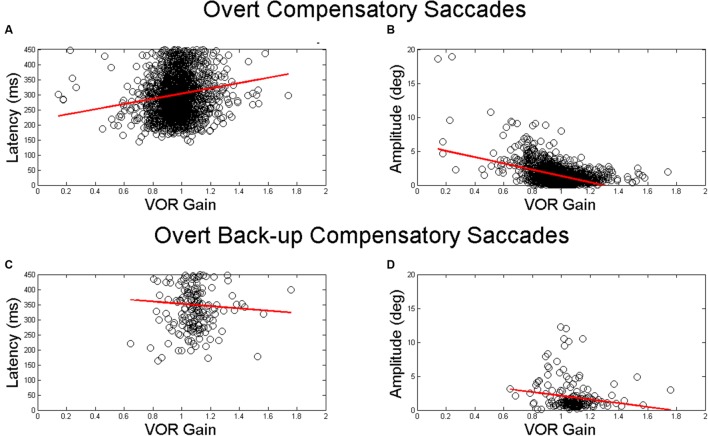
Relationship between VOR gain and first overt saccades. Relationship between VOR gain and overt saccade latency (A,C) and overt saccade amplitude (B,D). The top plots demonstrate the relationship for compensatory saccades, while the lower plots show the relationship for back-up saccades. The red line in each plot indicates the linear best fit for the relationship. Each point represents a single HIT.